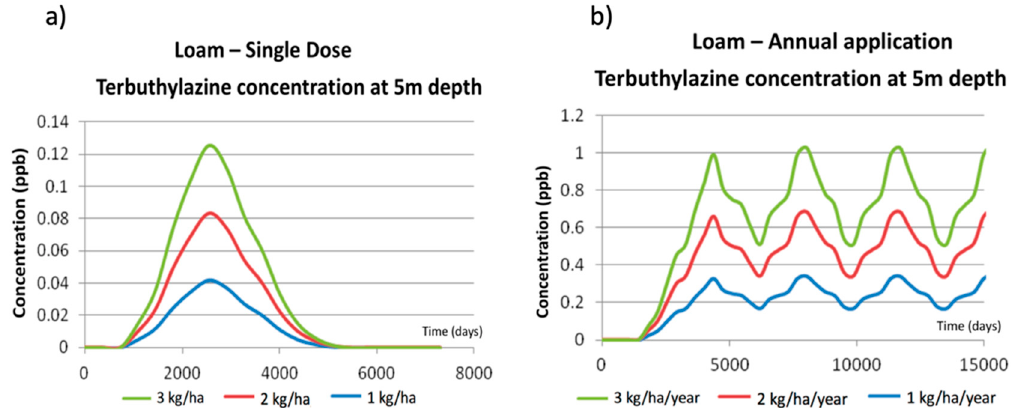
Figure 6. PRZM-GW terbuthylazine concentrations in loamy soil at 5 m depth. a) Single dose application. b) Annual application.